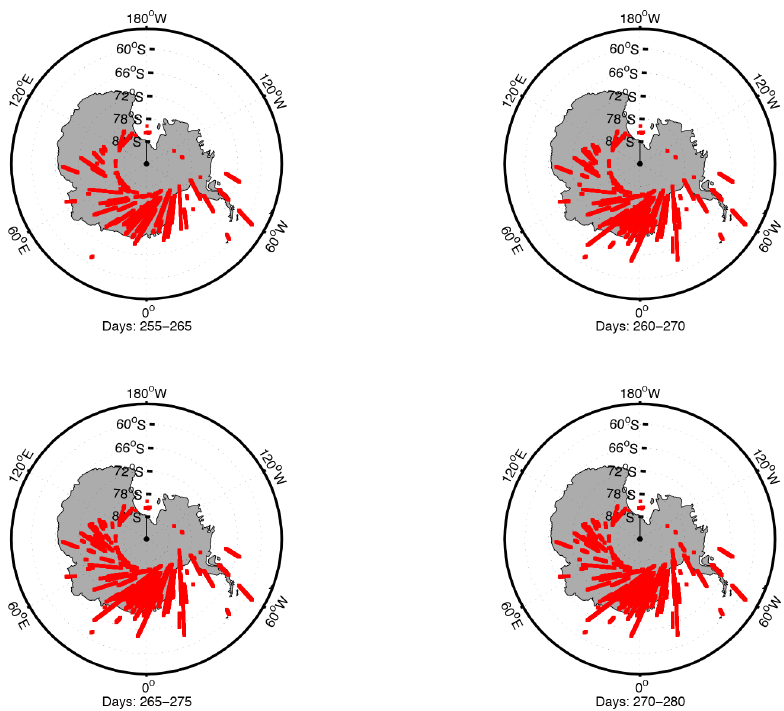
Figure 8. CALIPSO PSC flag over the 10 day bin intervals used in the ozone loss calculations for the 16.7km altitude layer.